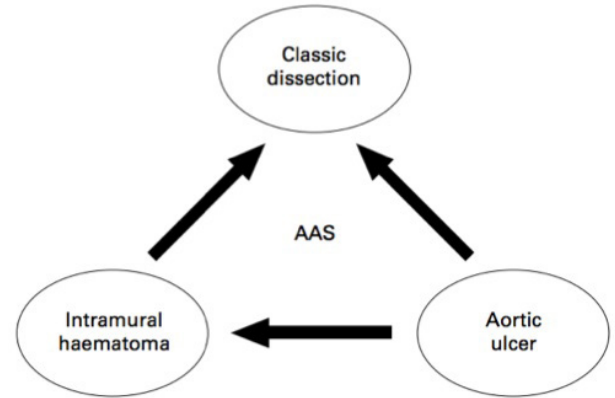
Fig. 3 – Illustrating diagram of acute aortic syndrome (AAS). Arrows indicate the possible progression of each of these aortic lesions [24]